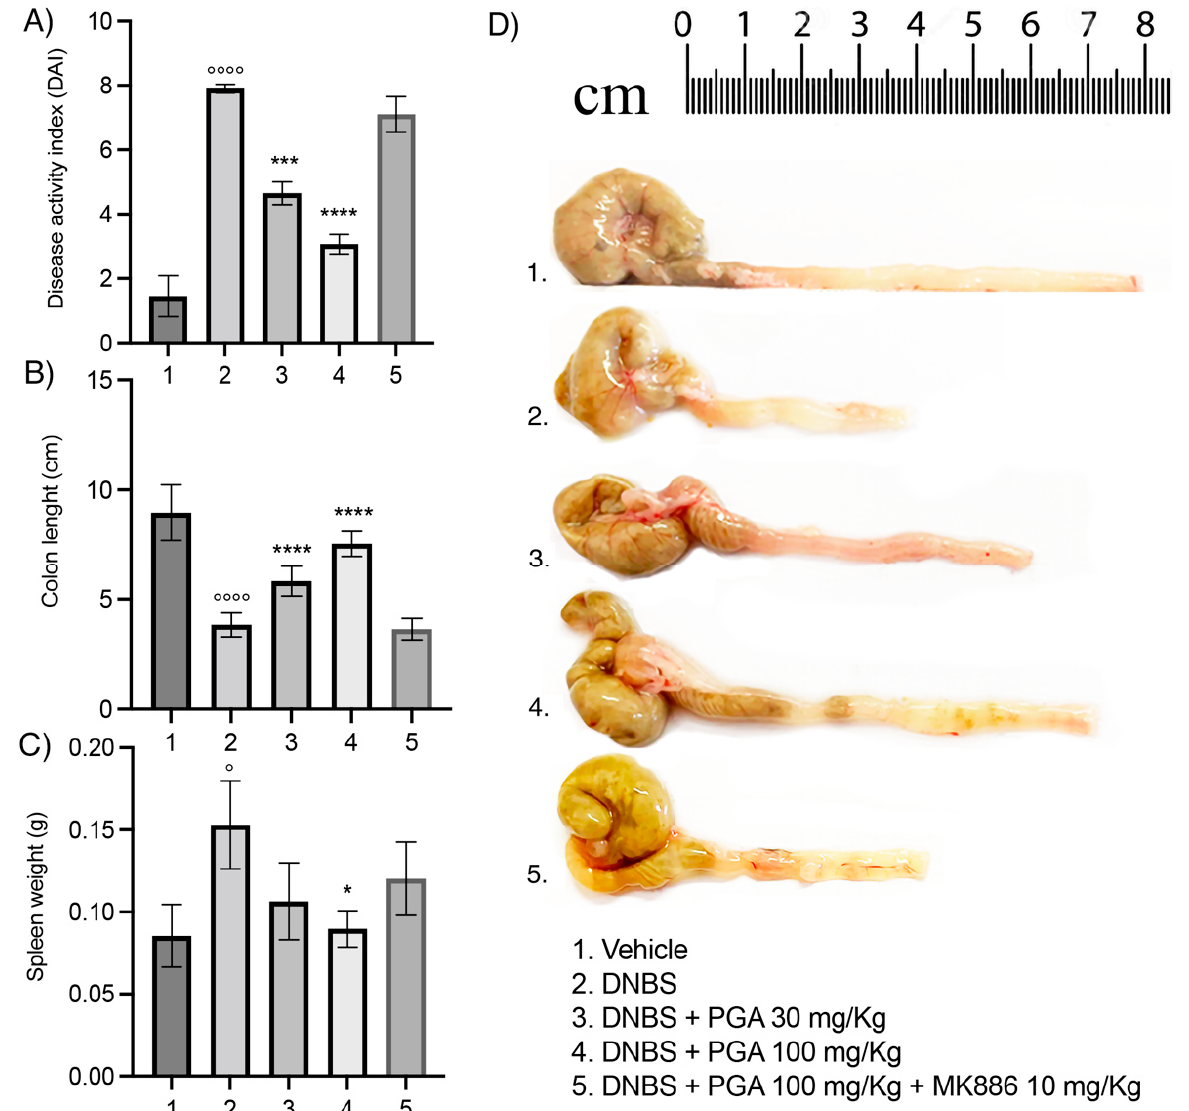
Figure 1. Micronized PGA significantly improves colitis hallmarks in PPAR- α -dependent manner. The effects of oral administration of micronized PGA on ( A ) DAI score, ( B , D ) colonic length, and ( C ) spleen weight in DNBS-treated mice. Results are expressed as the mean ± SD of n = 5 experiments ° p < 0.05 vs. vehicle; °°°° p < 0.0001 vs. vehicle; * p < 0.05 vs. DNBS; *** p < 0.001 vs. DNBS; **** p < 0.0001 vs. DNBS. Peroxisome proliferator-activated receptors- α (PPAR- α ); Disease Activity Index (DAI); 2,4-dinitrobenzene sulfonic acid (DNBS).